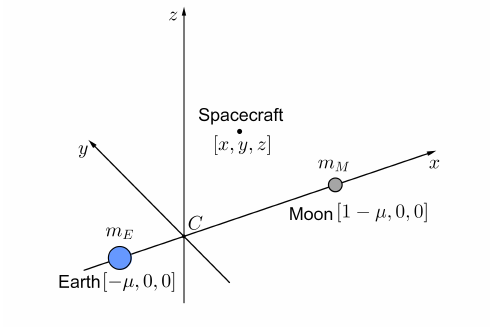
Figure 1. Rotating reference frame in the Earth–Moon circular restricted three-body